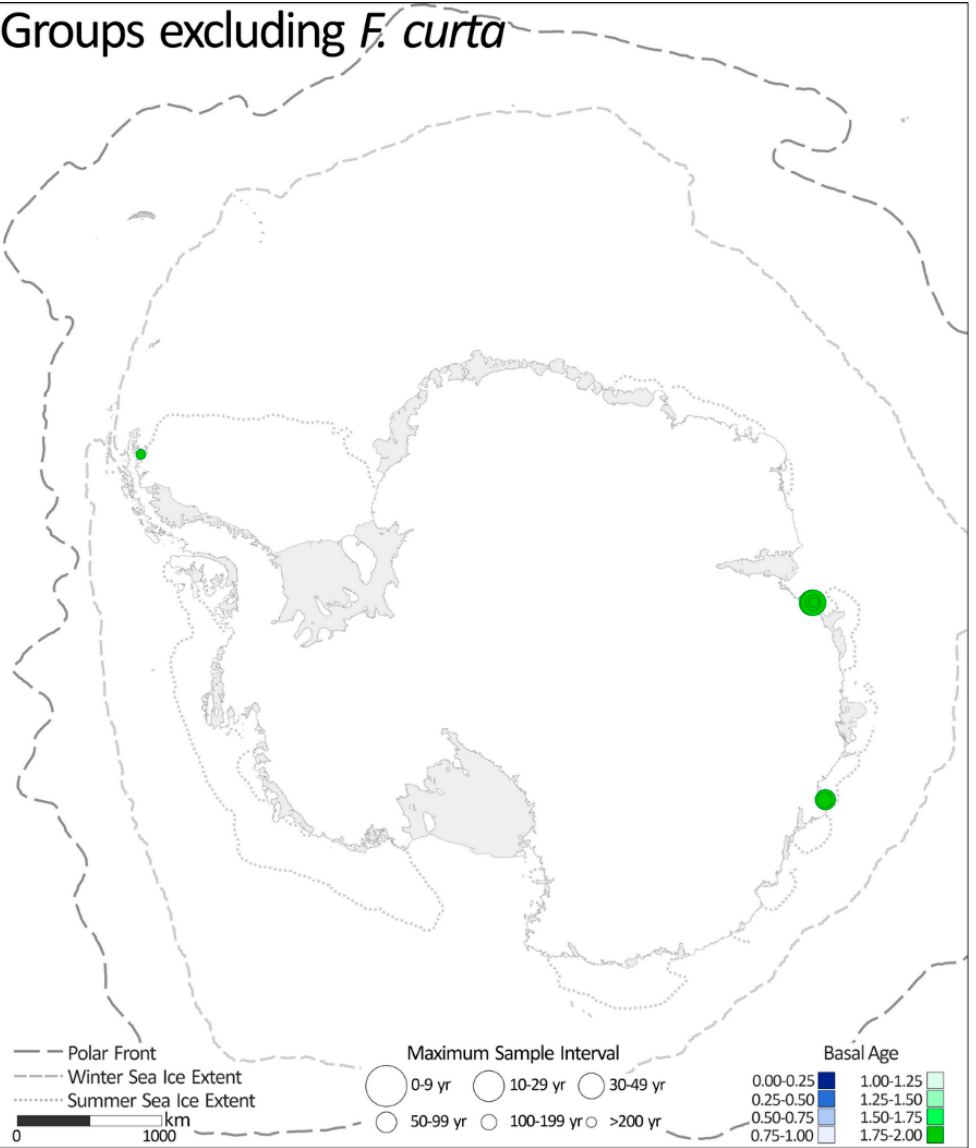
Figure 7. Map showing cores sites where groups of taxa excluding F. curta are used to reconstruct sea ice conditions. The symbol size reflects the resolution of the record and the color of the symbol indicates the basal age of the record between 0 and 2 ka BP.